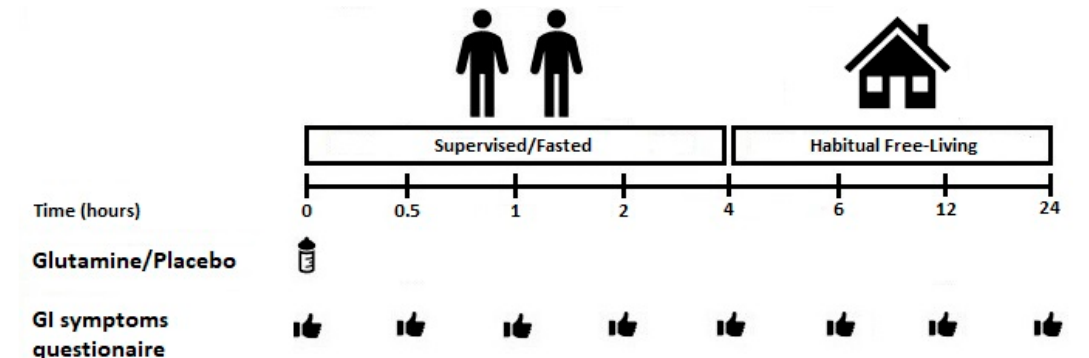
Figure 1. Schematic illustration of the experimental timings. GI: gastrointestinal.